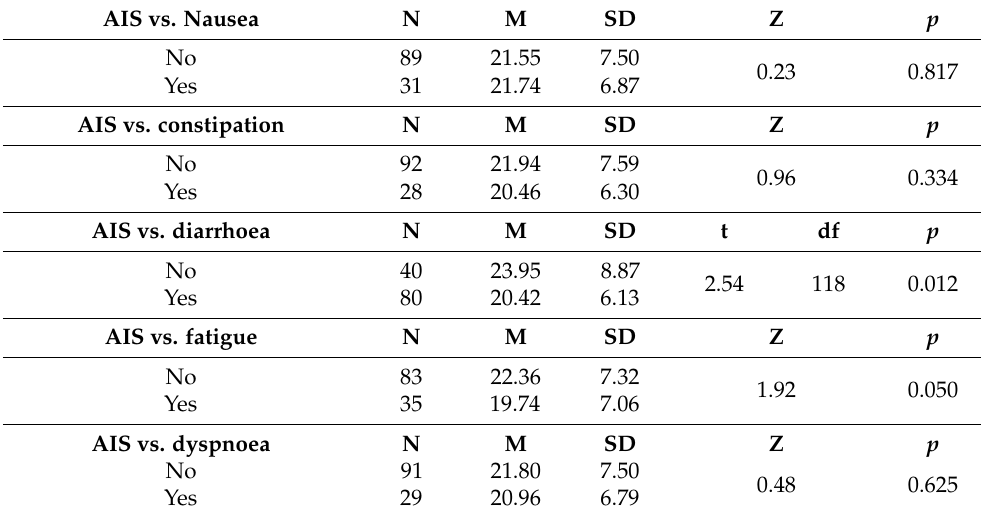
Table 11. Acceptance of illness versus disease-related symptoms.